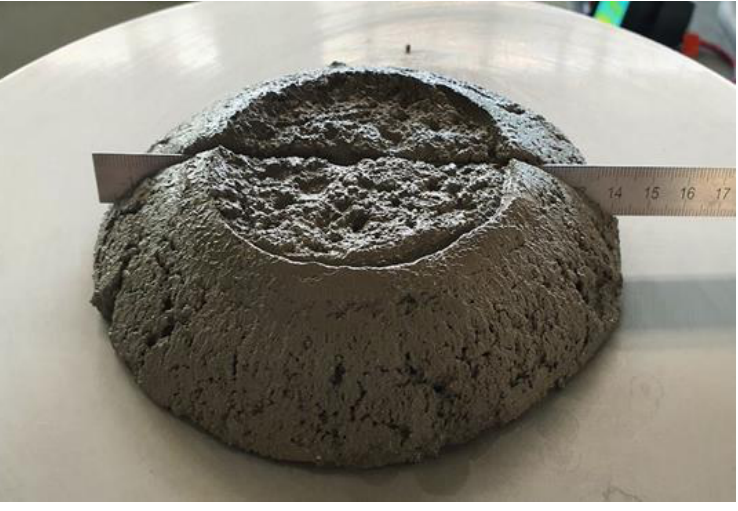
Figure 11. Consistency of fresh mortar with printable consistency.